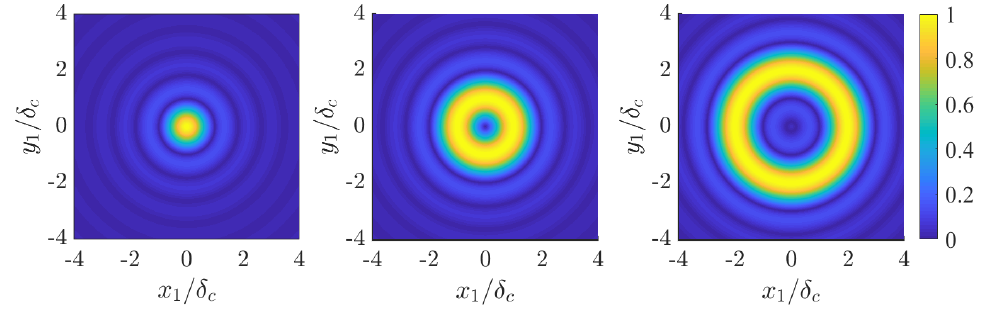
Figure 1. Absolute value of the degree of coherence relative to a point located at the following distances r 2 from the source center: r 2 = 0 ( left ); r 2 = 0.5 δ c ( center ), and r 2 = δ c ( right ).